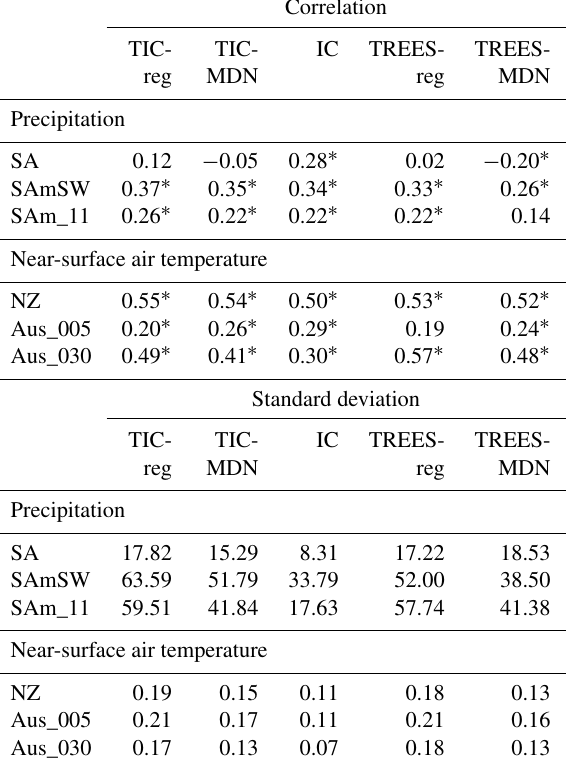
Table 4. Pearson correlation coefficient between the reconstructed and GMF near-surface air temperature and precipitation over 1901– 2000CE for different DA experiments (Table 1, with ice core prox- ies only, with tree-ring proxies only or with both) in different re- gions (Sect. 3) and proxy sites (Fig. 1). Standard deviation of the reconstruction in degrees Celsius ( ◦ C) (near-surface air tempera- ture) or in millimeters per year (mmyr − 1 ) (precipitation). SA stands for South America, SAmSW for the southwestern border of South America in the Andes where the TRW proxy sites are located and NZ for New Zealand. Aus refers to a site in New Zealand and SAm in South America. Asterisks stand for significant correlation coeffi- cients at the 95% confidence level. Correlation TIC- TIC- IC TREES- TREES-